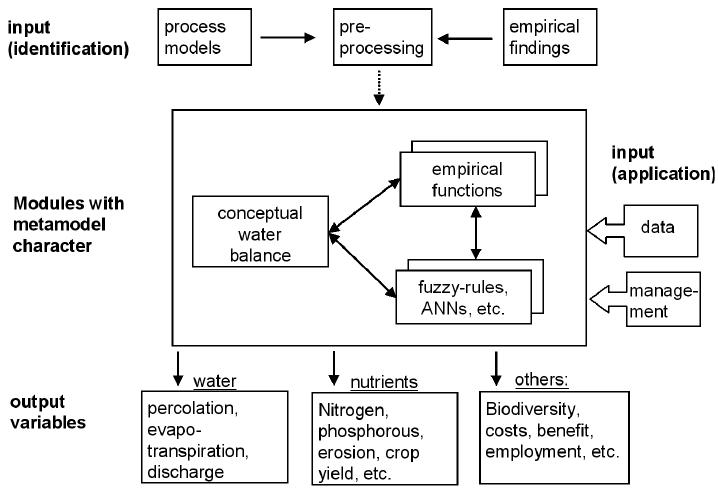
Fig. 8. Conceptual scheme of a metamodel